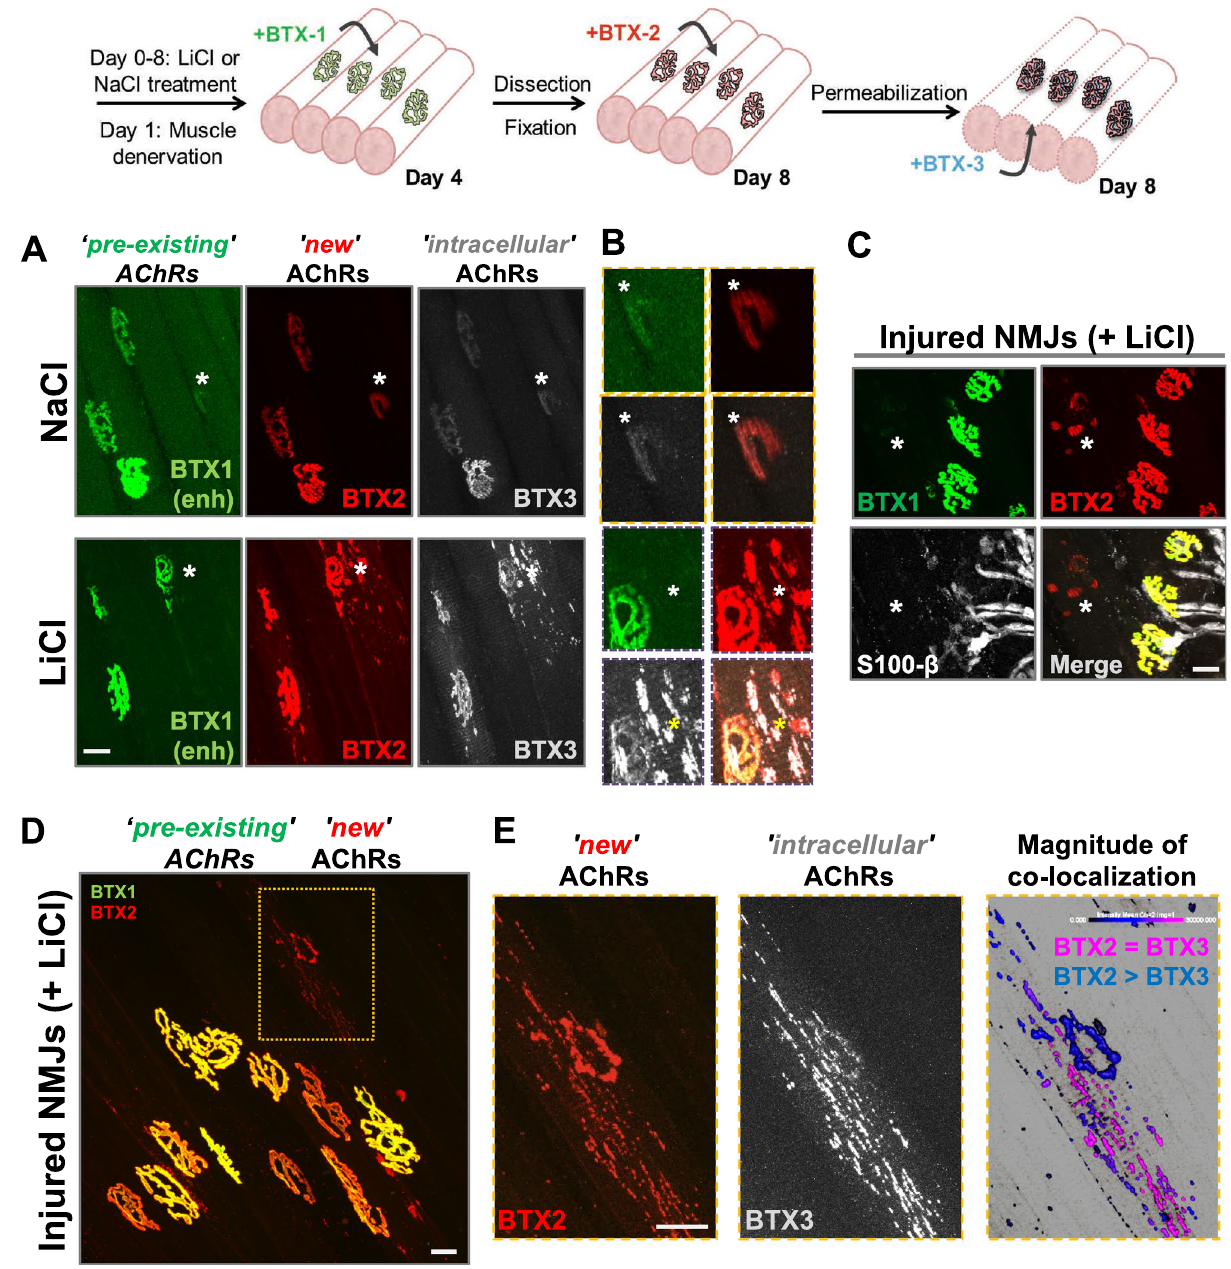
Figure 6. Lithium stimulates the formation of unstable nAChR clusters in non-synaptic regions of denervated muscle fibres. ( A ) Experimental design used to address the origin and stability of denervation-associated nAChR clusters. Since one day before facial nerve cut, lithium or sodium (control) chloride were subcutaneously injected on top of the LAL muscle daily until BTX2 labelling. The initial surface nAChR pool was labelled 3 days after facial nerve cut (BTX1) while newly incorporated nAChRs (BTX2) were stained 7 days after nerve cut. Intracellular nAChRs were labelled by tissue permeabilization and subsequent incubation with AlexaFluor647-BTX (BTX3, ‘intracellular’ nAChRs). Confocal imaging was performed along entire muscle fibres both in synaptic and non-synaptic regions of the sarcolemma. The AlexaFluor488-BTX fluorescence intensity was digitally enhanced (BTX1 enh) to evidence positive or negative BTX1 staining in non-synaptic regions (asterisks) for each experimental condition. Bar = 20 µm. ( B ) Representative higher magnification images of non-synaptic regions for each condition. Bar = 20 µm. ( C ) To analyse if BTX2-only structures detected in lithium-treated denervated muscles were located in non-synaptic muscle regions, immunohistochemistry for Schwann cells using anti S100-β was performed along with BTX1 and BTX2 staining on mice subjected to facial nerve cut. Bar = 20 µm. ( D ) Further characterization of non-synaptic nAChR clusters is evidenced by co-localization of BTX2 and BTX3. ( E ) Higher magnification images of the dotted line square in D reveal total or partial co-localization between newly incorporated nAChRs (BTX2) and intracellular nAChRs (BTX3) after IMARIS® analyses. Briefly, regions where BTX2 signal was also positive for BTX3 are pseudo-coloured magenta (BTX2 = BTX3). In turn, regions positive for BTX2 with undetectable BTX3 signal are pseudo-coloured blue (BTX2 > BTX3). N = 3 animals per group. Bar = 20